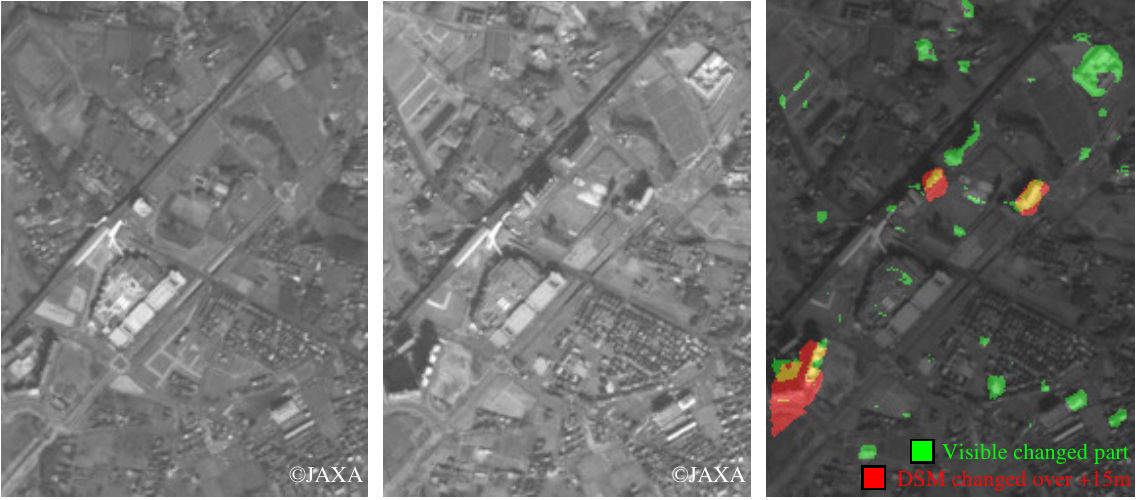
Figure 5: Example of change detected image Left: 1 st orthoimage, Center: 2 nd orthoimage, Right: change detected image overlayed with 2 nd orthoimage